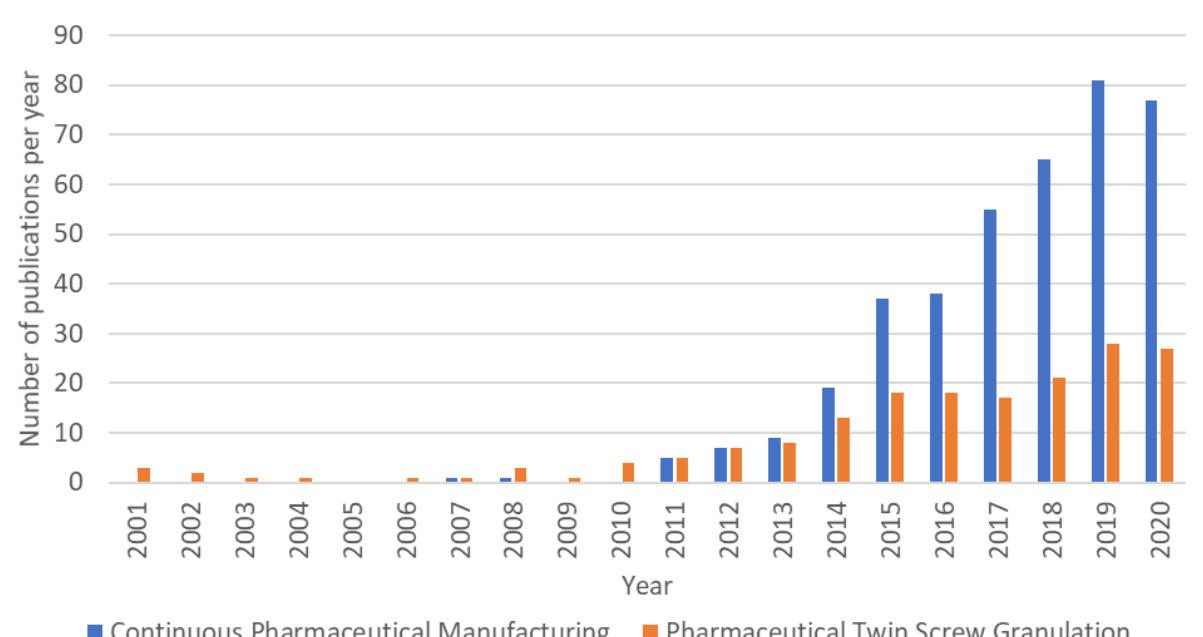
Figure 3. Evolution in publications on continuous pharmaceutical manufacturing and pharmaceutical twin screw granulation, indexed in PubMed as Continuous-Manufacturing AND Pharmaceutical (blue) and Pharmaceutical AND Twin-Screw AND Granulation (orange), respectively.